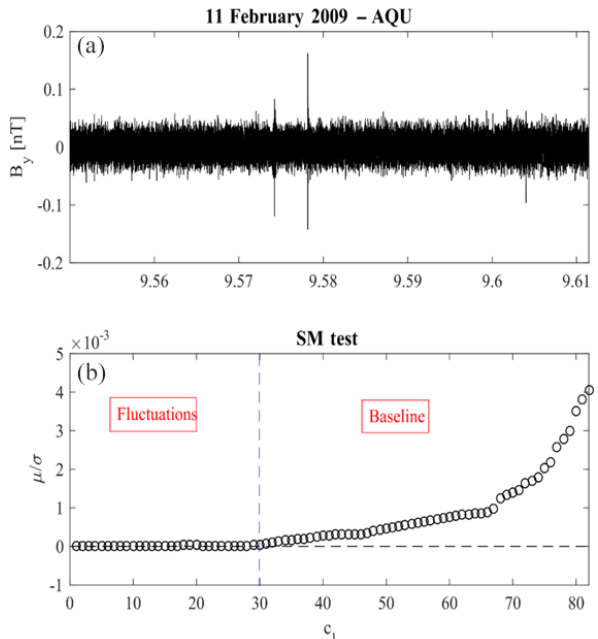
Figure 2. An example of the application of the SM test (b) to the magnetic field observations (a) over l’Aquila on 11 February 2009 from 09:33 to 09:39UT.